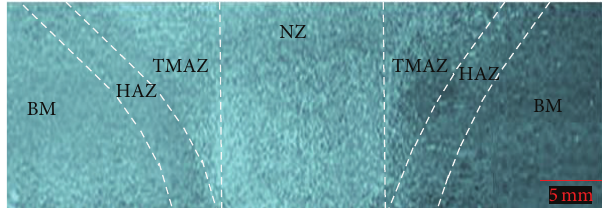
Figure 8: Optical image showing the macroscopic features in a cross section of the FSW butt